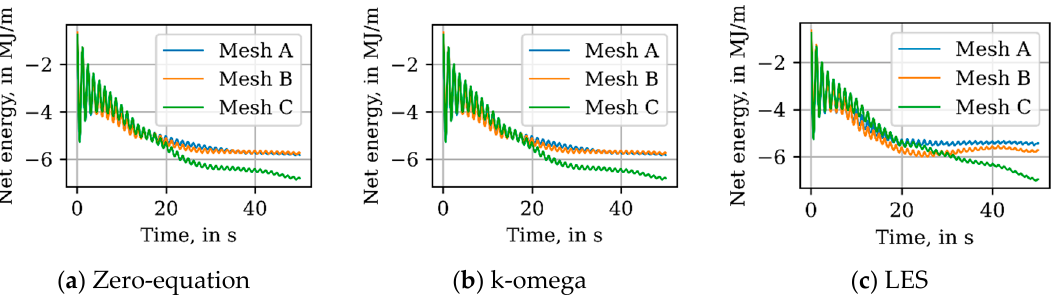
Figure 5. Time series of the net energy through A d for the three mesh configurations and for the turbulence models: ( a ) zero-equation, ( b ) k-omega, and ( c ) large eddy simulation (LES).